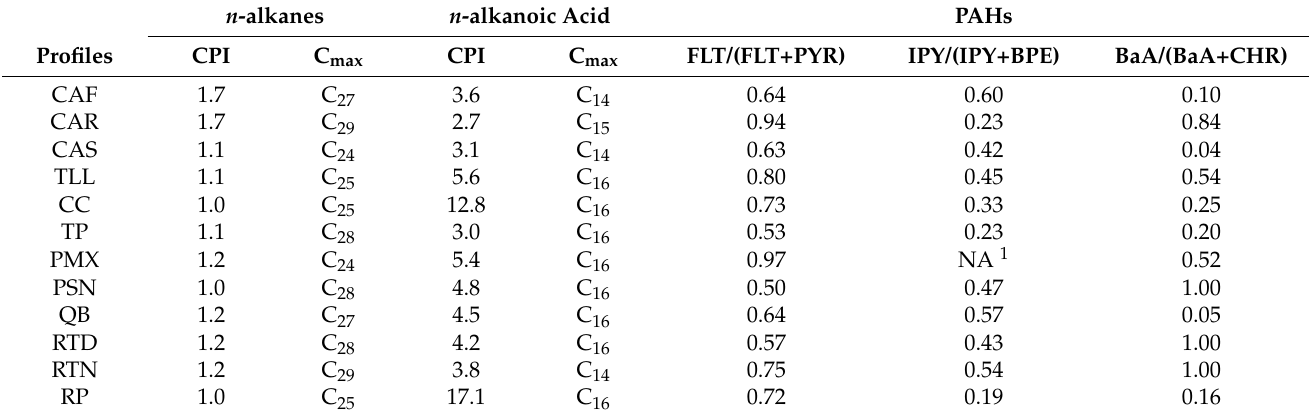
Figure 4. Quantified EOM mass levels of each family of organic compounds in the total OC of each source emission profile. Definition of source profile codes are presented in Table 1. Table 5. Carbon preference index and diagnostic PAH ratios for each emission source